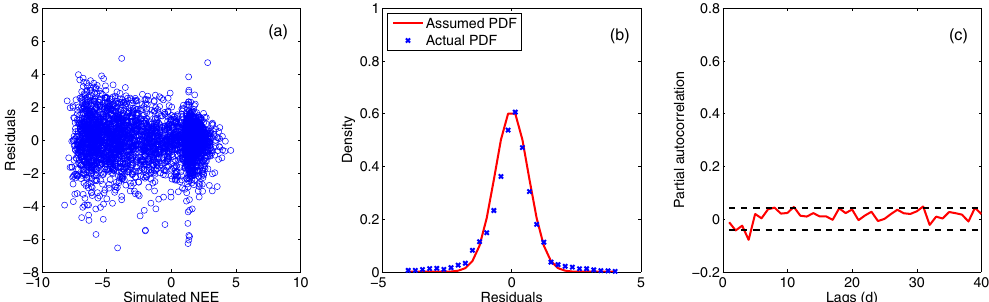
Figure 12. Residual analysis of the calibration using Gaussian likelihood with heteroscedastic and correlated errors: (a) residuals vs. sim- ulated NEE; (b) assumed and actual probability density functions of residuals; and (c) partial autocorrelation coefficients of residuals with 95% significance levels (black dashed